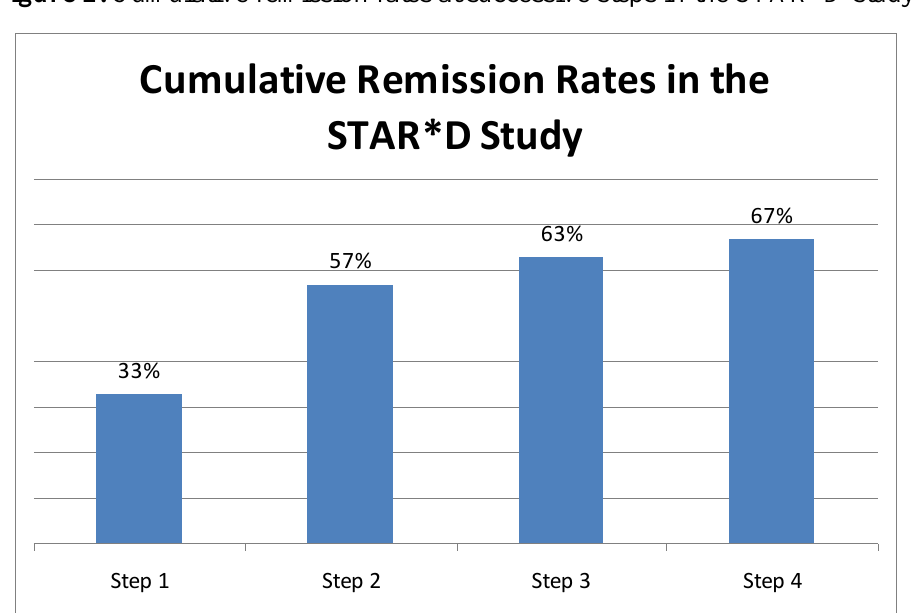
Figure 2. Cumulative remission rates at successive steps in the STAR*D